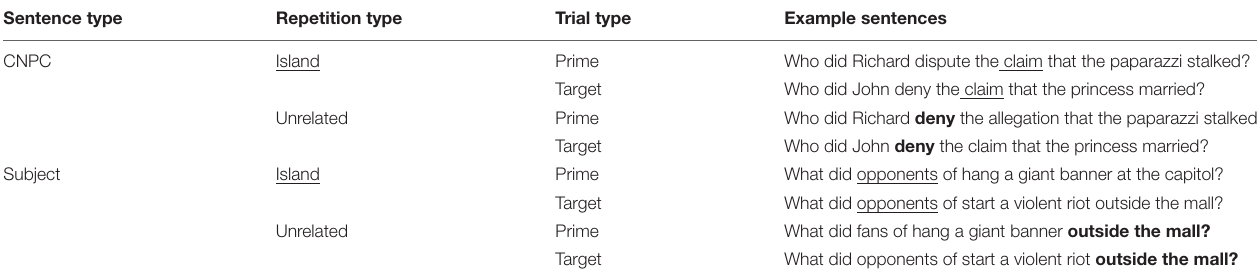
TABLE 1 | Sample sentences (primes and targets) used in Experiments 1 and